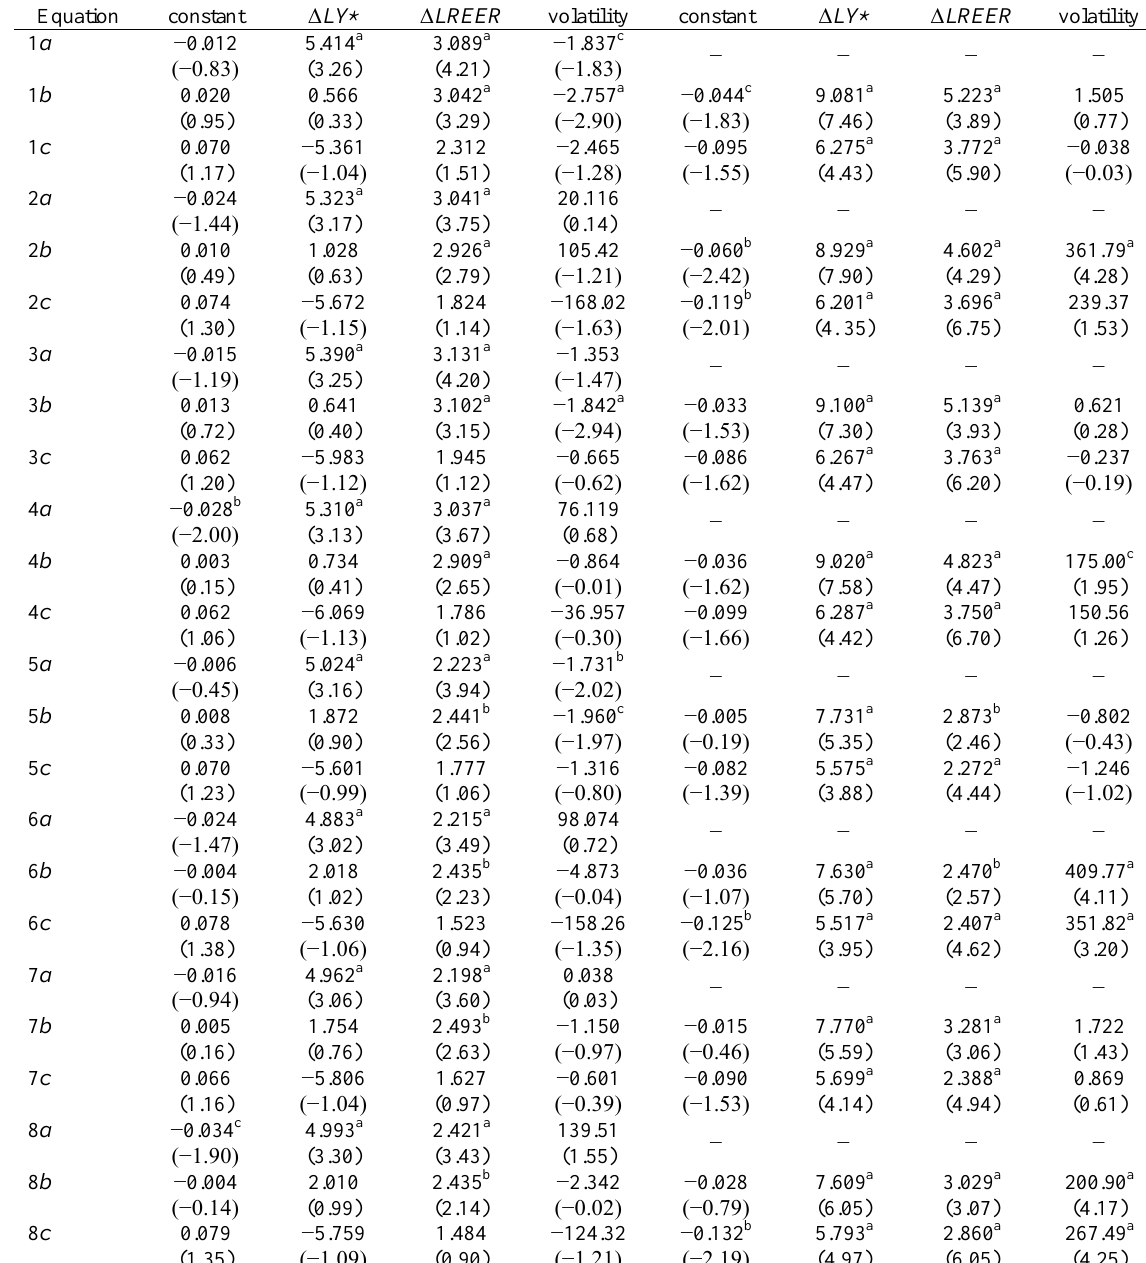
Table 9 : Exports and exchange rate volatility: